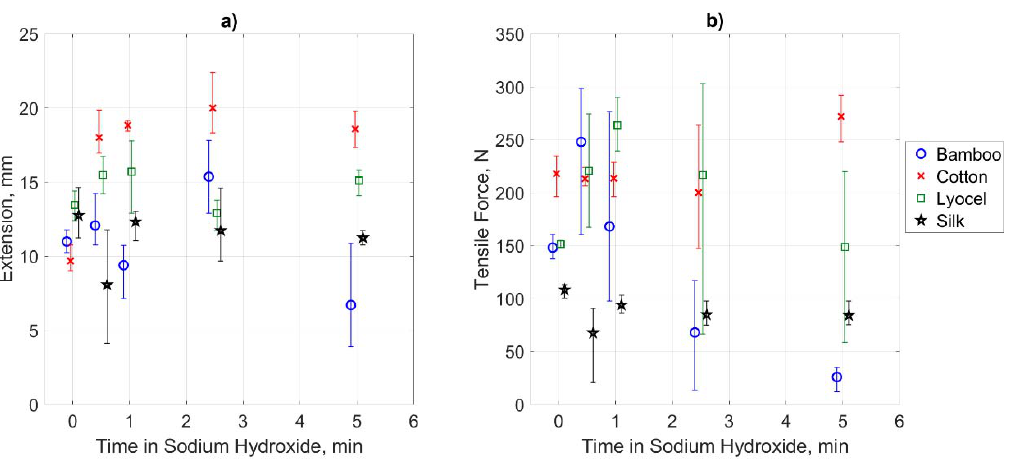
Figure 2. ( a ) Breaking force of fabric samples as a function of time in sodium hydroxide. ( b ) Elongation at breaking force.